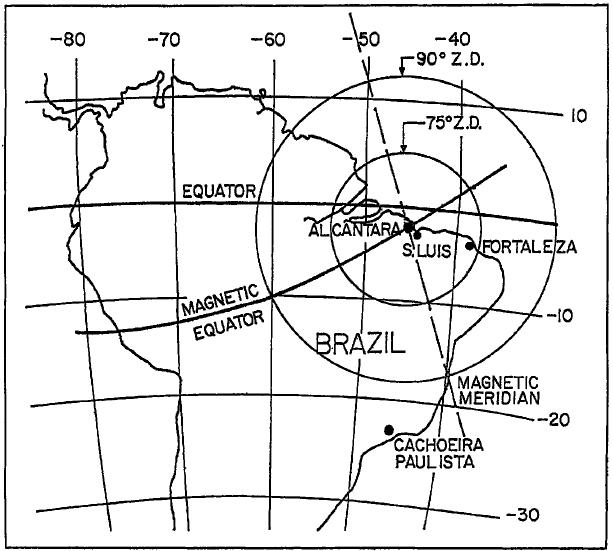
Fig. 1. The OI 630 nm emission all-sky imaging system field of view at 75 (cid:176) and 90 (cid:176) zenith angles at 300 km altitude from